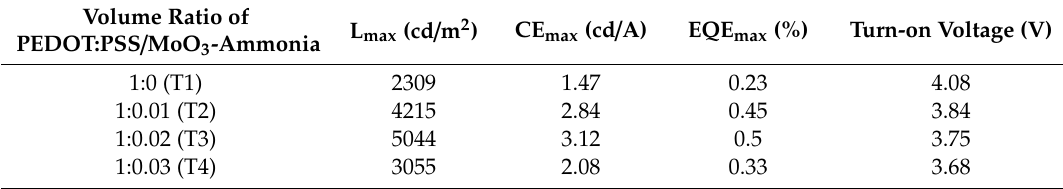
Table 2. Summary of the device parameters of PeLEDs (device T1, T2, T3, T4) with a